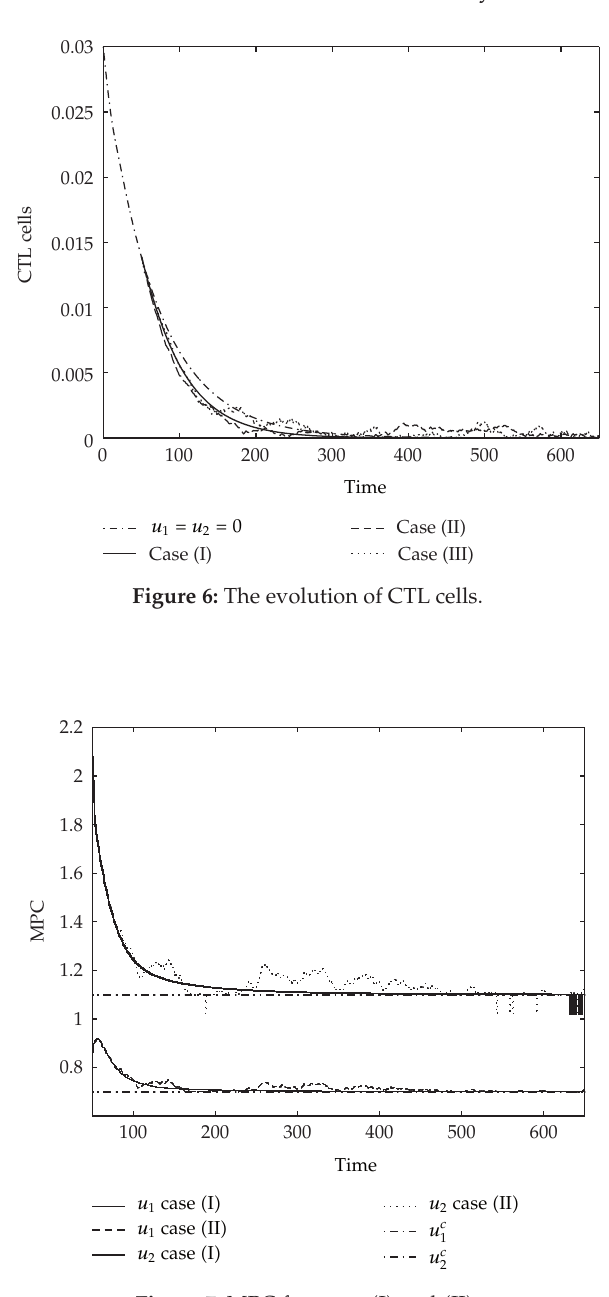
Figure 7: MPC for cases (cid:2) I (cid:3) and (cid:2) II (cid:3)